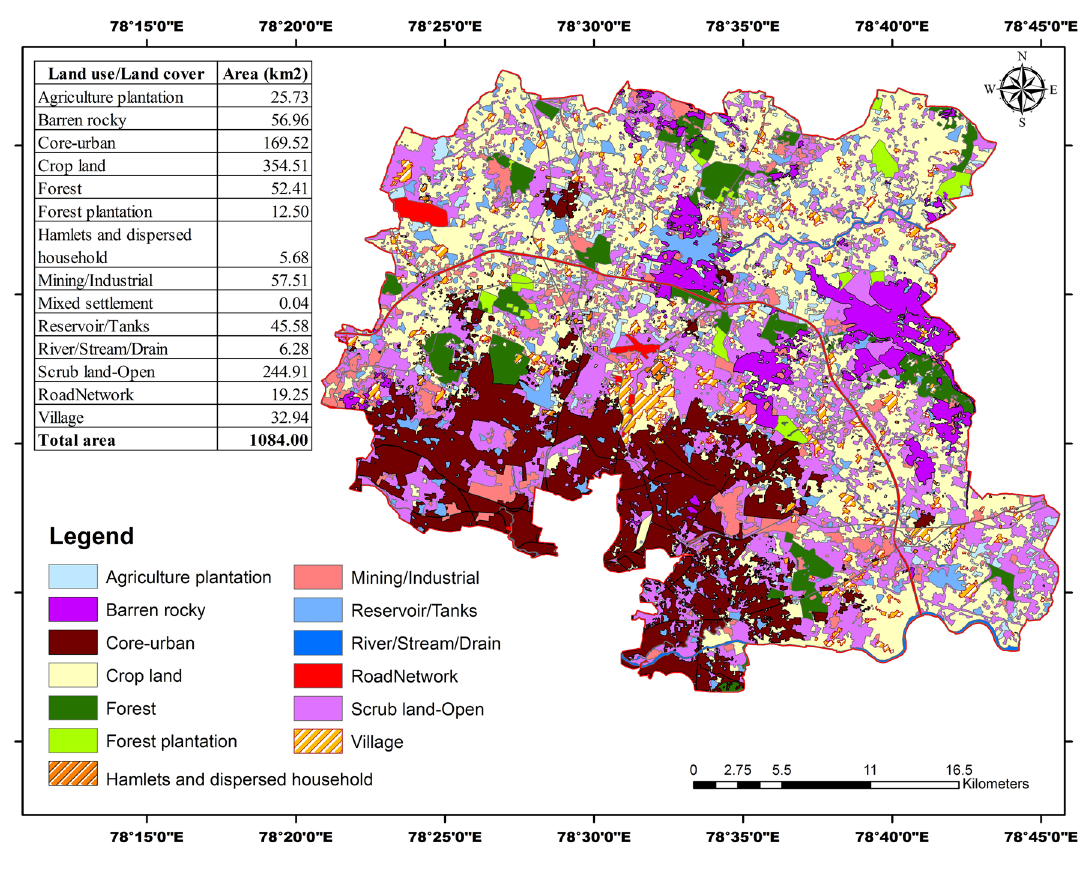
Fig. 2 Land use/Land cover map of the study area Table 1 Year wise rain fall distribution in the study area (in